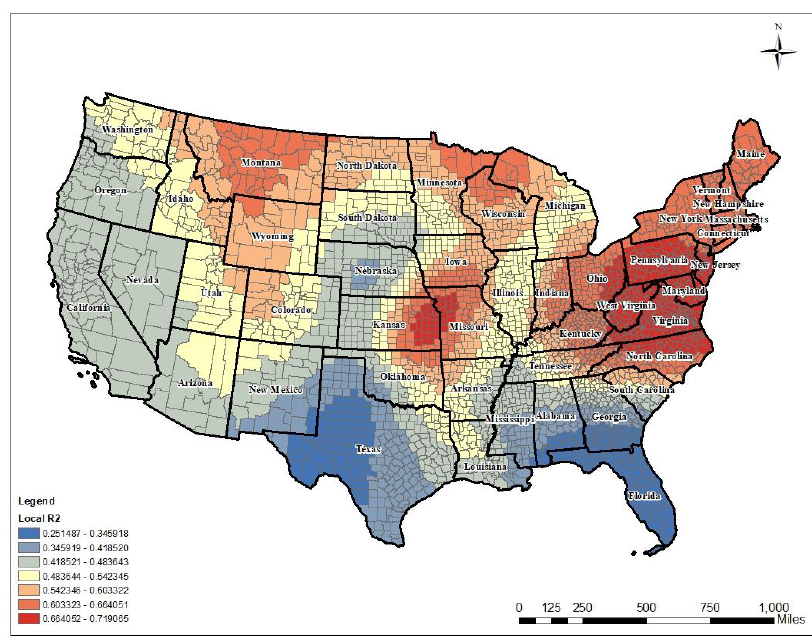
Figure 3. Local R-squared values.